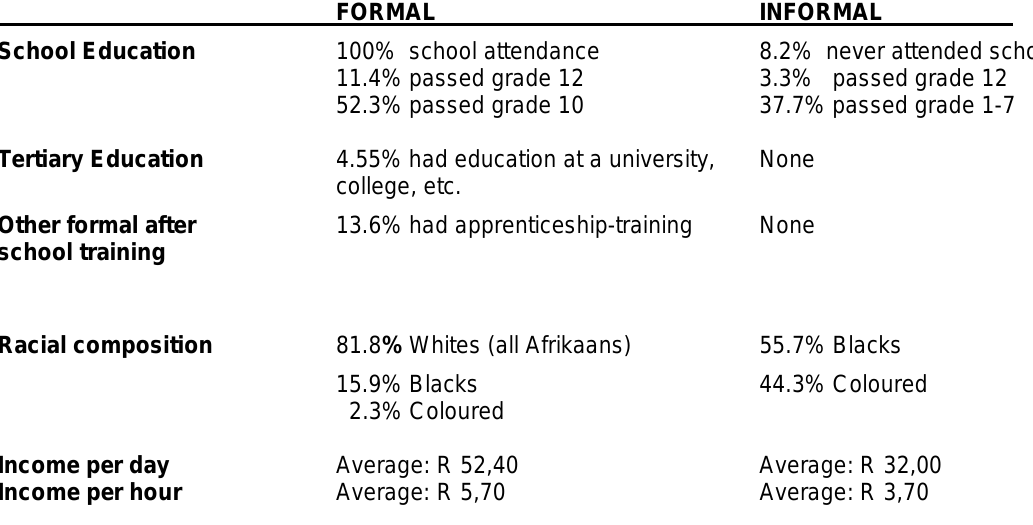
Table 1: Educational features and income earned of car guards in Bloemfontein: